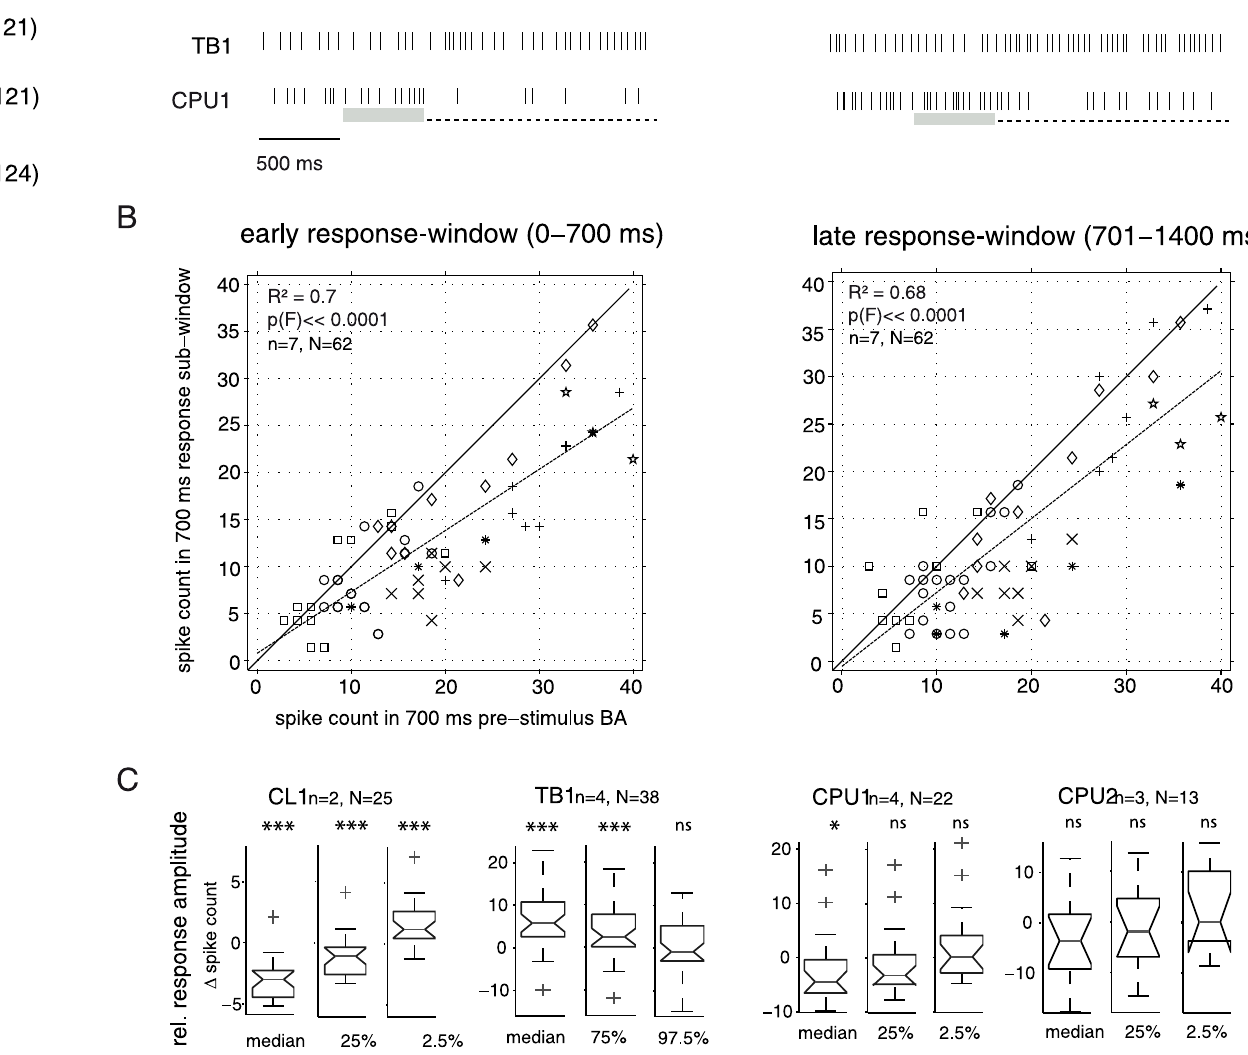
Fig 6. Modulation of responses to moving small-field objects by variable background activity. A. Raster plots show selected responses to a translating small-field square (dashed line: stimulus window) which are modulated by relatively low states (left subplot) and relatively high states (right subplot) of precedent background activity (BA). The relevant period of background activity may roughly cover the last 500 ms (grey shading) preceding the stimulus. B. Correlation analysis in CPU neurons. Spike counts within the first (second) 700 ms-window during stimulus presentation were plotted against those in the 700 ms-window of background activity directly preceding the stimulus. Data points close to or above the bisecting line correspond to trials that lacked the inhibitory response typical for CPU neurons; strongest responses are reflected by data points closest to the x-axis. Data were obtained from 3 CPU1- and 4 CPU2 neurons and cover 62 responses to the first stimulus in sequences of single small-field squares translating against a blank background; different plot marks correspond to different neurons. Plot marks are not scaled to the frequency of observations, thus identical values from the same experiment appear as a single data point. Dotted lines show linear regressions. C. Response amplitudes compared to different states of background activity. Box plots show distributions of relative response amplitudes (changes in spike rate relative to different levels of background activity). These were calculated for responses to the first stimulus in a respective sequence of small-field squares translating against a blank background (N responses from n neurons). For estimation of relative response amplitudes, we subtracted the spike rates of different levels of background activity (1s bins), obtained from the same respective cell throughout the entire experiment. These levels include the median and two additional quantiles of the background activity's spike count distribution that lie beyond the median in the same side of the distribution as expected for responses. In case of the inhibitory responses in CL- and CPU neurons, the 25% and 2.5% quantile of the spike rate distribution were used. For the excitatory responses of TB neurons, the 75% and 97.5% quantile provide relevant normalization. Indicated above each box-plot is the result of a two-sided sign test for zero median ( * p corr < 0.05, ** p corr < 0.01, *** p corr < 0.001, ns not